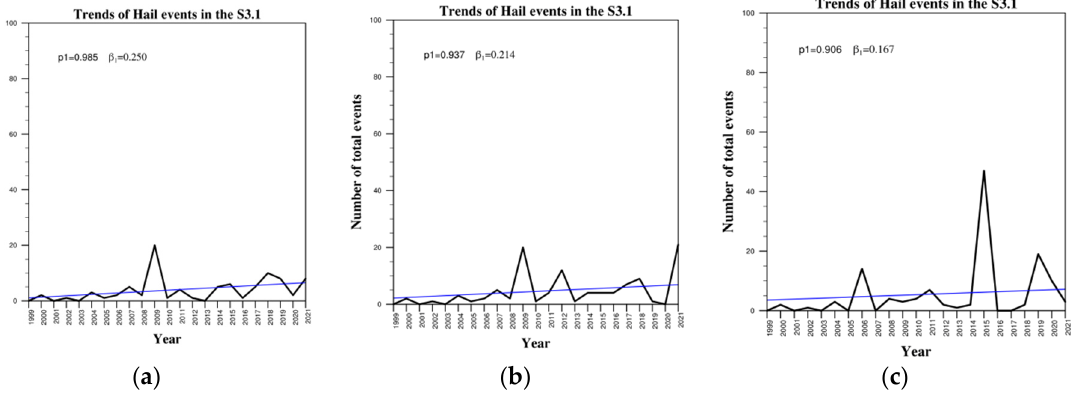
Figure 10. Temporal evolution of the annual number of H events for the sector 3.1 considering the three-time series in Table 2, i.e., time series-1 N15-N18-NPP ( a ), time series-2 N15-N18-MOB ( b ), and time series-3 N15-MOA-MOC ( c ).